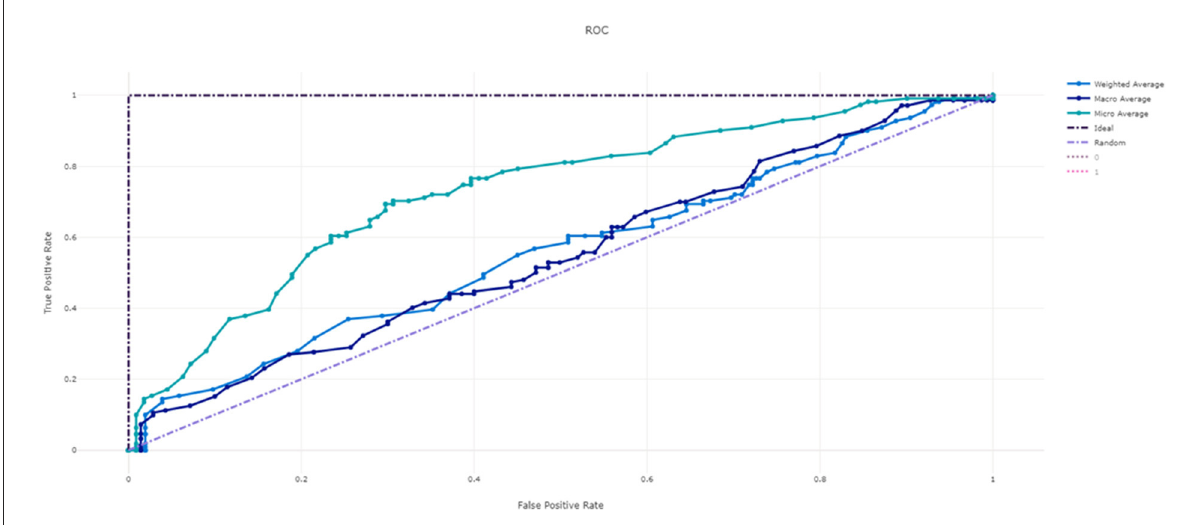
FIGURE5 ROC curve of Random Forest model predicting fall risk among hospitalized elderly.